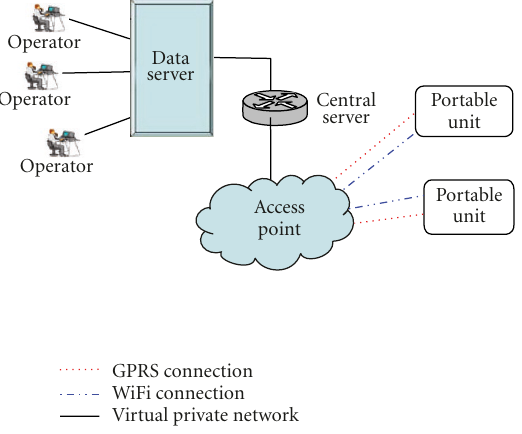
Figure 3: Hospital central system and hosted internal clients.